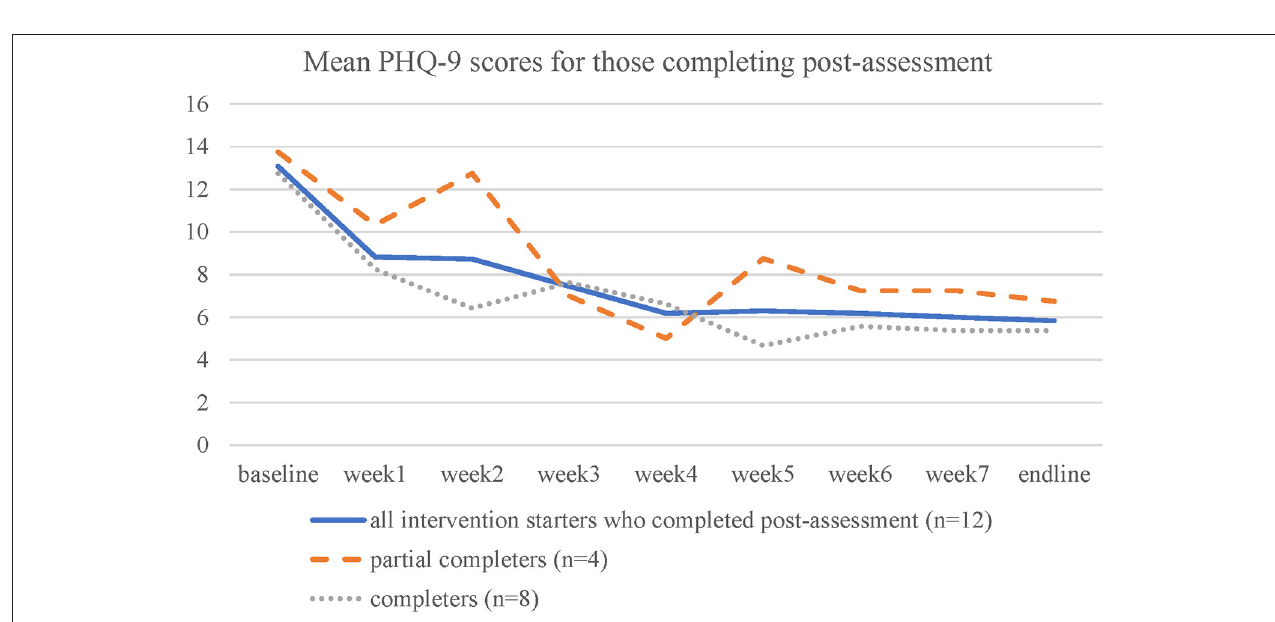
FIGURE 4 | Mean PHQ-9 score in each week for participants who did some part of the intervention and completed